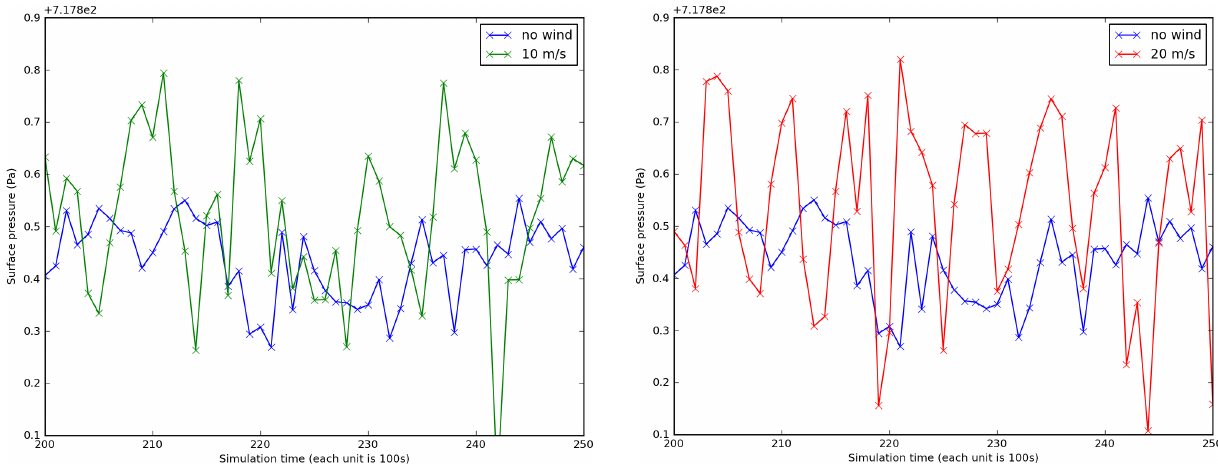
Fig. 2. Fluctuations of surface pressure with time at the central grid point of a Martian LES. On the left (right), a case with background wind of 10ms − 1 (20ms − 1 ) is compared to a case with no background wind. Instantaneous model outputs are shown every 100s between approximately 12:00 and 13:00LT (LES integration timestep is 1.5s). Higher frequency outputs show similar periodic patterns except for the added “noise” of lesser amplitude which corresponds to turbulent eddies of smaller scale than convective cells shown in Fig. 1.